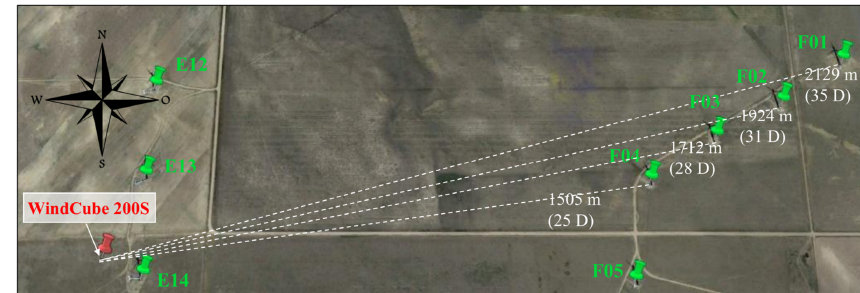
Figure 4. Satellite map of deployment of Halo StreamLine XR on 11 October 11 2018. Source: ©Google Maps.